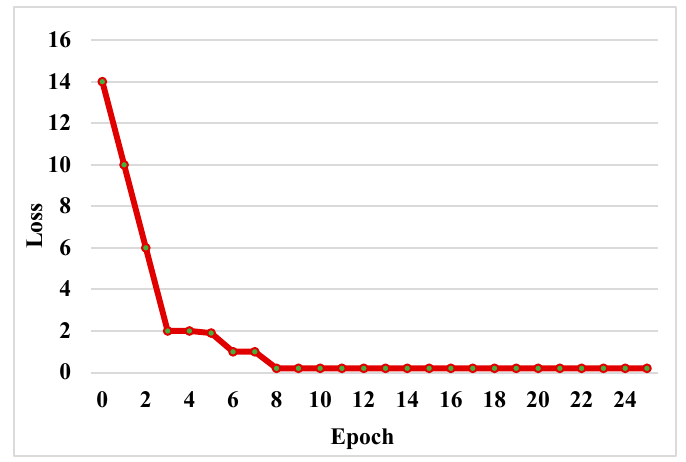
Figure 9. Training loss analysis.